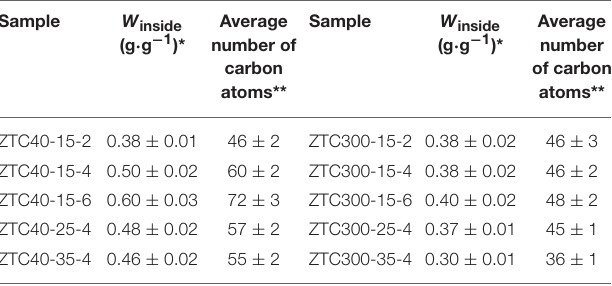
* Weight of carbon inside FAU template—excluding the graphitic layers on the external surface of zeolite (g carbon · g − 1 zeolite). ** Average number of carbon atoms per supercage of FAU estimated from W inside .